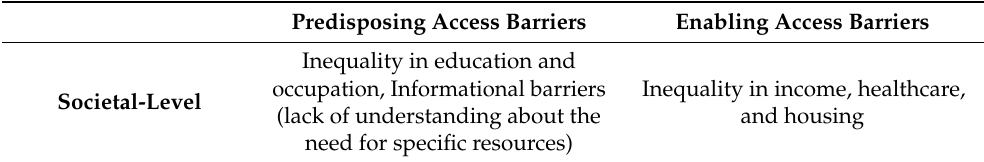
Table 1. Mutable predisposing and enabling access barriers posed by society, institutions, and individuals that impact food